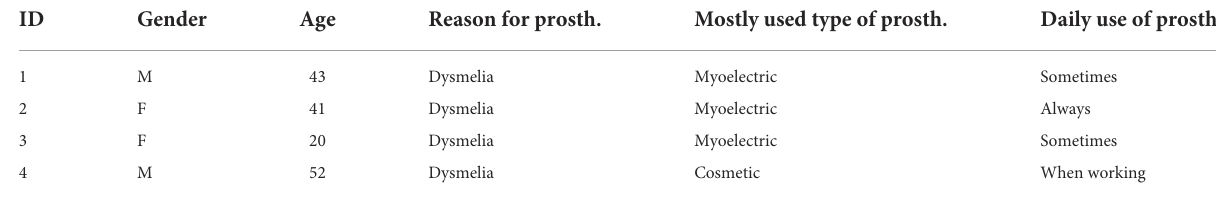
TABLE 1 Demographic and clinical overview of the trial participants.